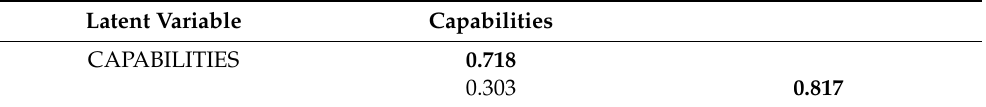
Table 2. Fornell-Larcker Criterion.